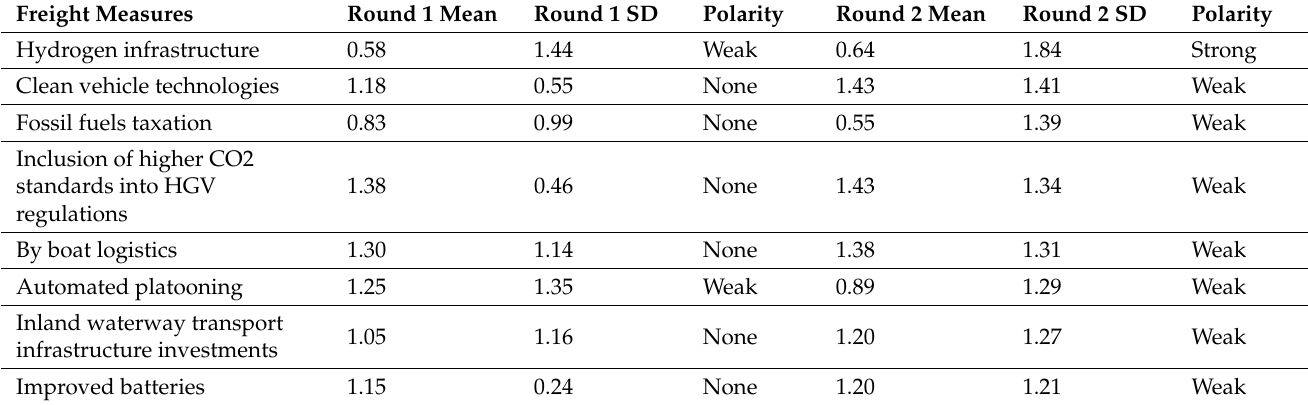
Table 8. Proposed policy measures with controversial views among the Delphi